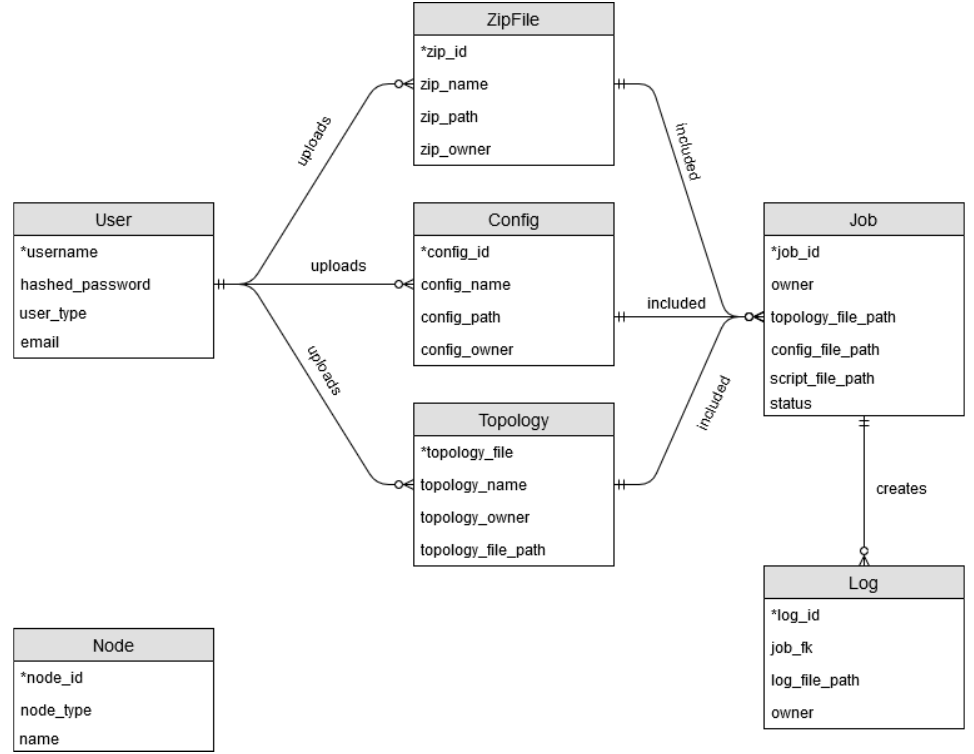
Figure 6. Log Retrieval Sequence